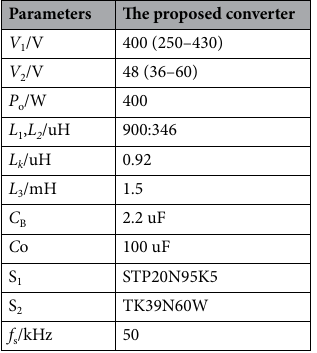
Table 4. The parameters of the proposed